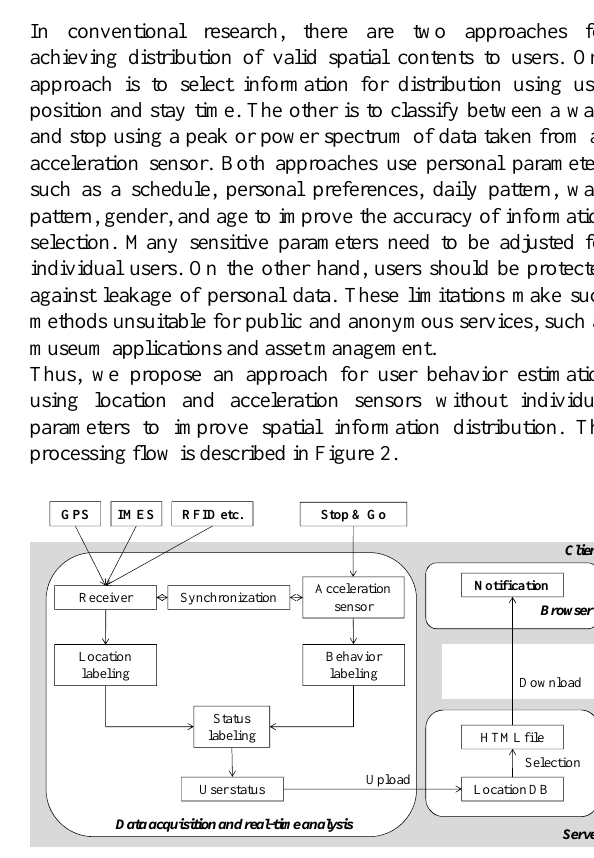
Figure 2. The processing flow with five components